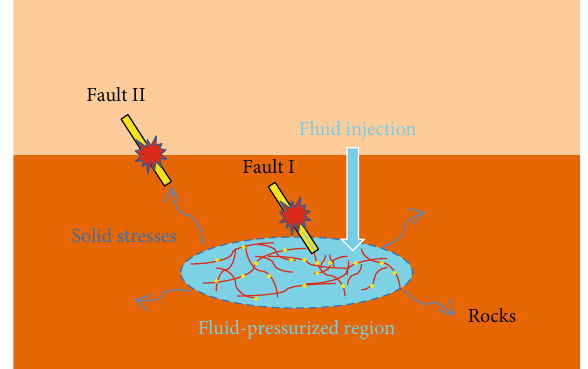
Figure 2: The diagram of the space relationship between the fault and fl uid-pressurized